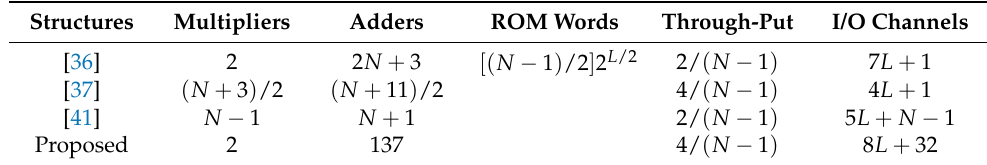
Table 3. Comparison of the hardware complexity of various DST designs.